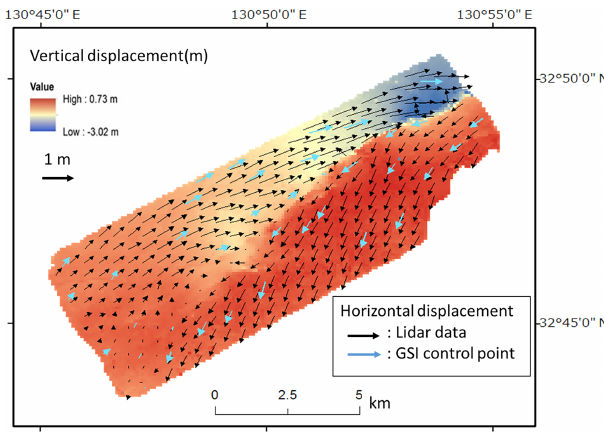
Figure 2. Estimated three-dimensional coseismic displacement af- ter the mainshock of the 2016 Kumamoto earthquake. The black arrows and the shaded colors indicate the horizontal and vertical displacements obtained from lidar (Moya et al., 2017). The blue arrows indicate the horizontal displacements at the control points measured by the Geospatial Information Authority of Japan (2016).